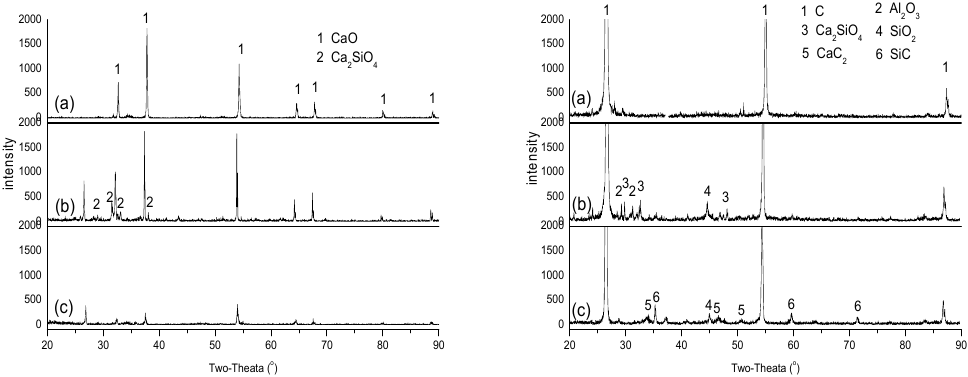
Figure 3. XRD analyses: ( a ) CaO (left) and ash-C (right) alone at 1500 °C; ( b ) CaO (left) and ash-C (right) when they were in close contact at 1500 °C; ( c ) CaO (left) and ash-C (right) when they were in close contact at 1700 °C.